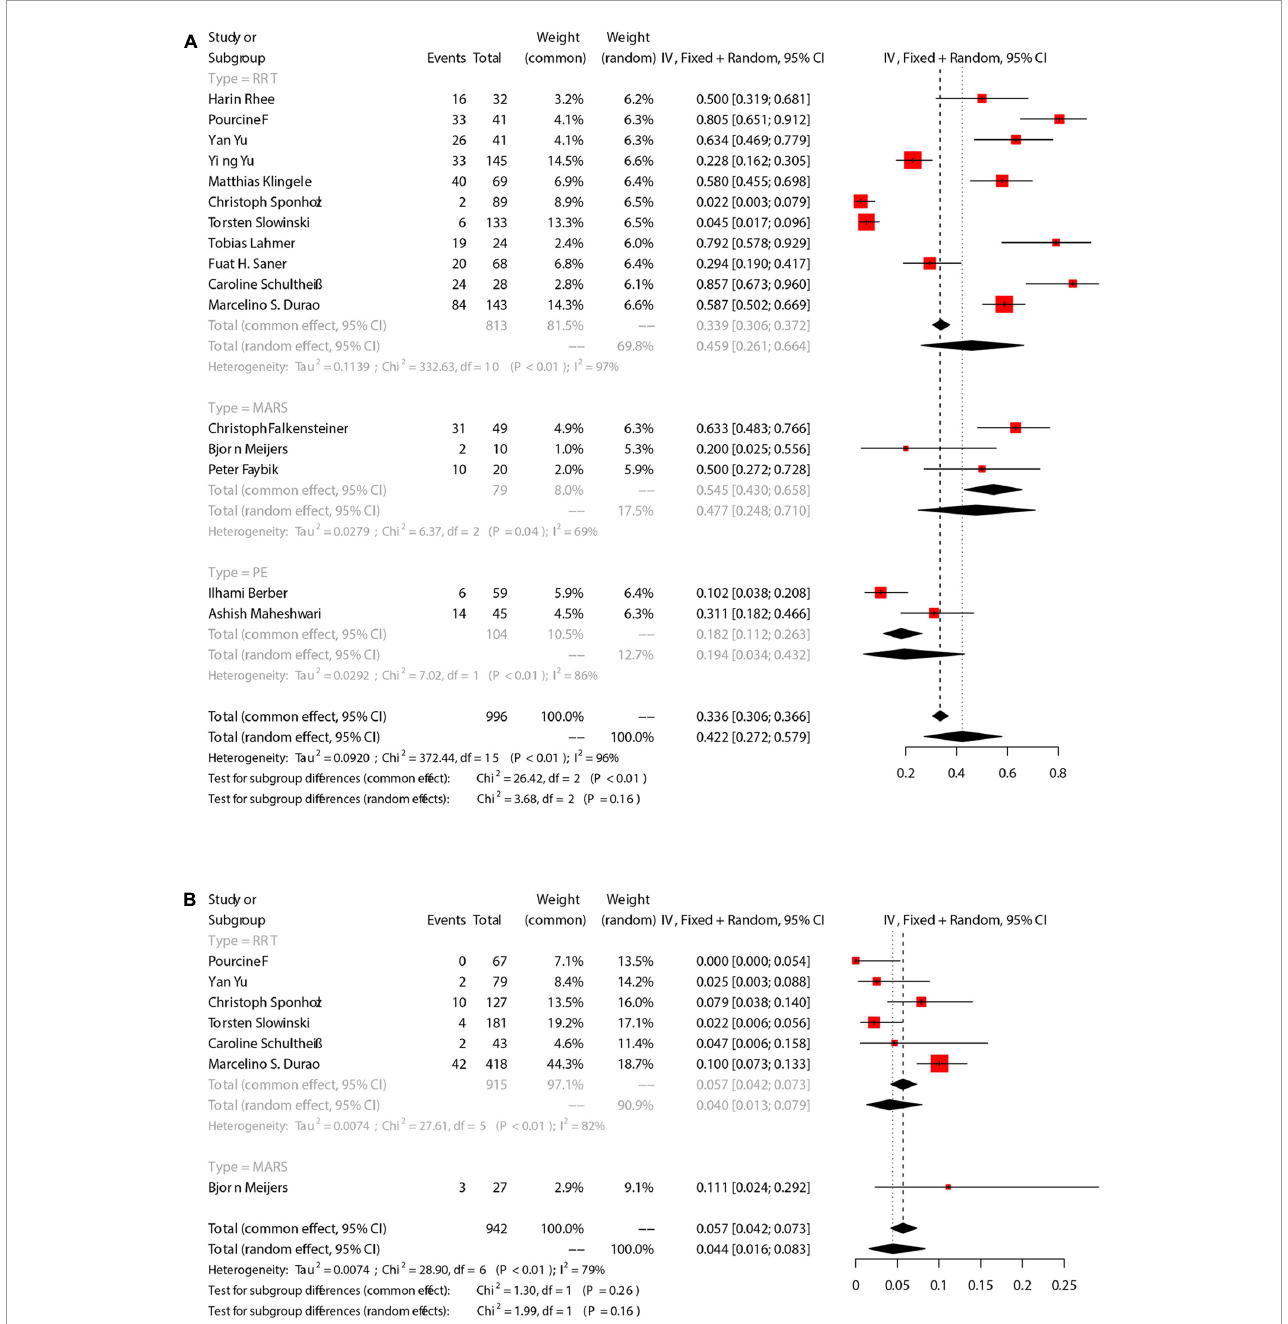
FIGURE2 The pooled rates (95% CI) of patient death (A) and filter clotting (B) . RRT, renal replacement therapy; MARS, molecular adsorbent recirculation system; PE, plasma exchange; CI, confidence